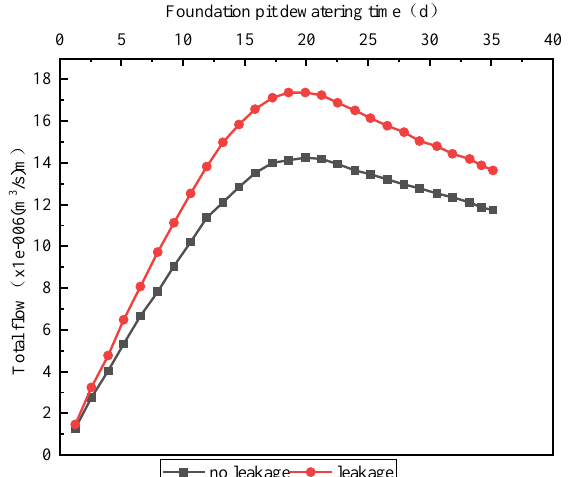
Figure 10. The curve of the total flow rate of the leaky and non-leaky envelope with precipitation time.